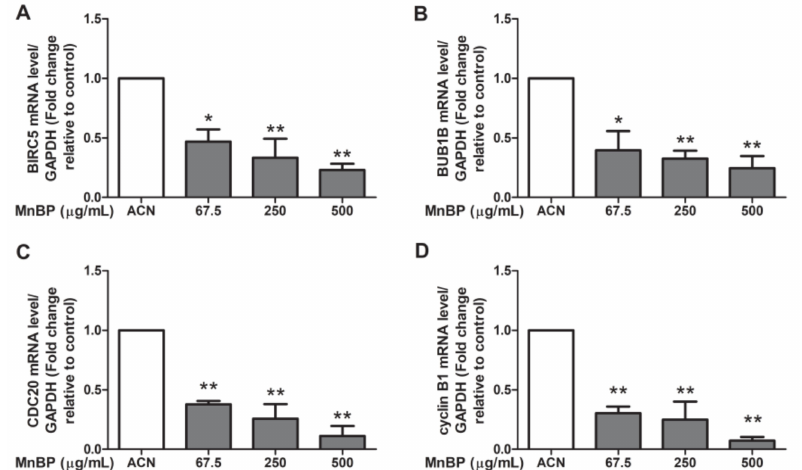
Figure 2. E ff ects of MnBP treatment on the expression of ( A ) BIRC5 , ( B ) BUB1B , ( C ) CDC20 , and ( D ) cyclin B1 in human granulosa cells. The expression levels of mRNA for the baculoviral inhibitor of apoptosis repeat-containing 5 ( BIRC5 ), mitotic checkpoint serine / threonine kinase beta ( BUB1B ), cell division cycle 20 ( CDC20 ), and cyclin B1 were measured using the reverse transcription quantitative polymerase chain reaction. Human granulosa cells were seeded overnight and treated with solvent control (ACN) and 67.5, 250, or 500 µ g / mL of MnBP for 24 h. The expression levels of BIRC5 , BUB1B , CDC20 , and cyclin B1 were normalized to that of glyceraldehyde-3-phosphate dehydrogenase (GAPDH). Data are shown as mean ± SD compared to those of the solvent control. * p < 0.05. ** p < 0.01.